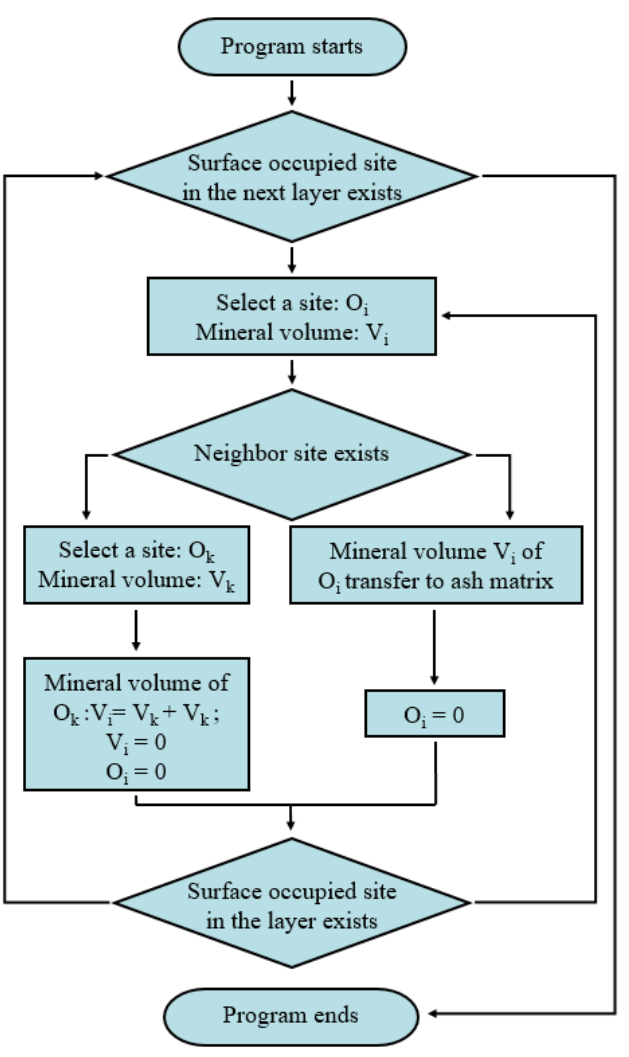
Figure 2. Procedure of program for char conversion and mineral partitioning.